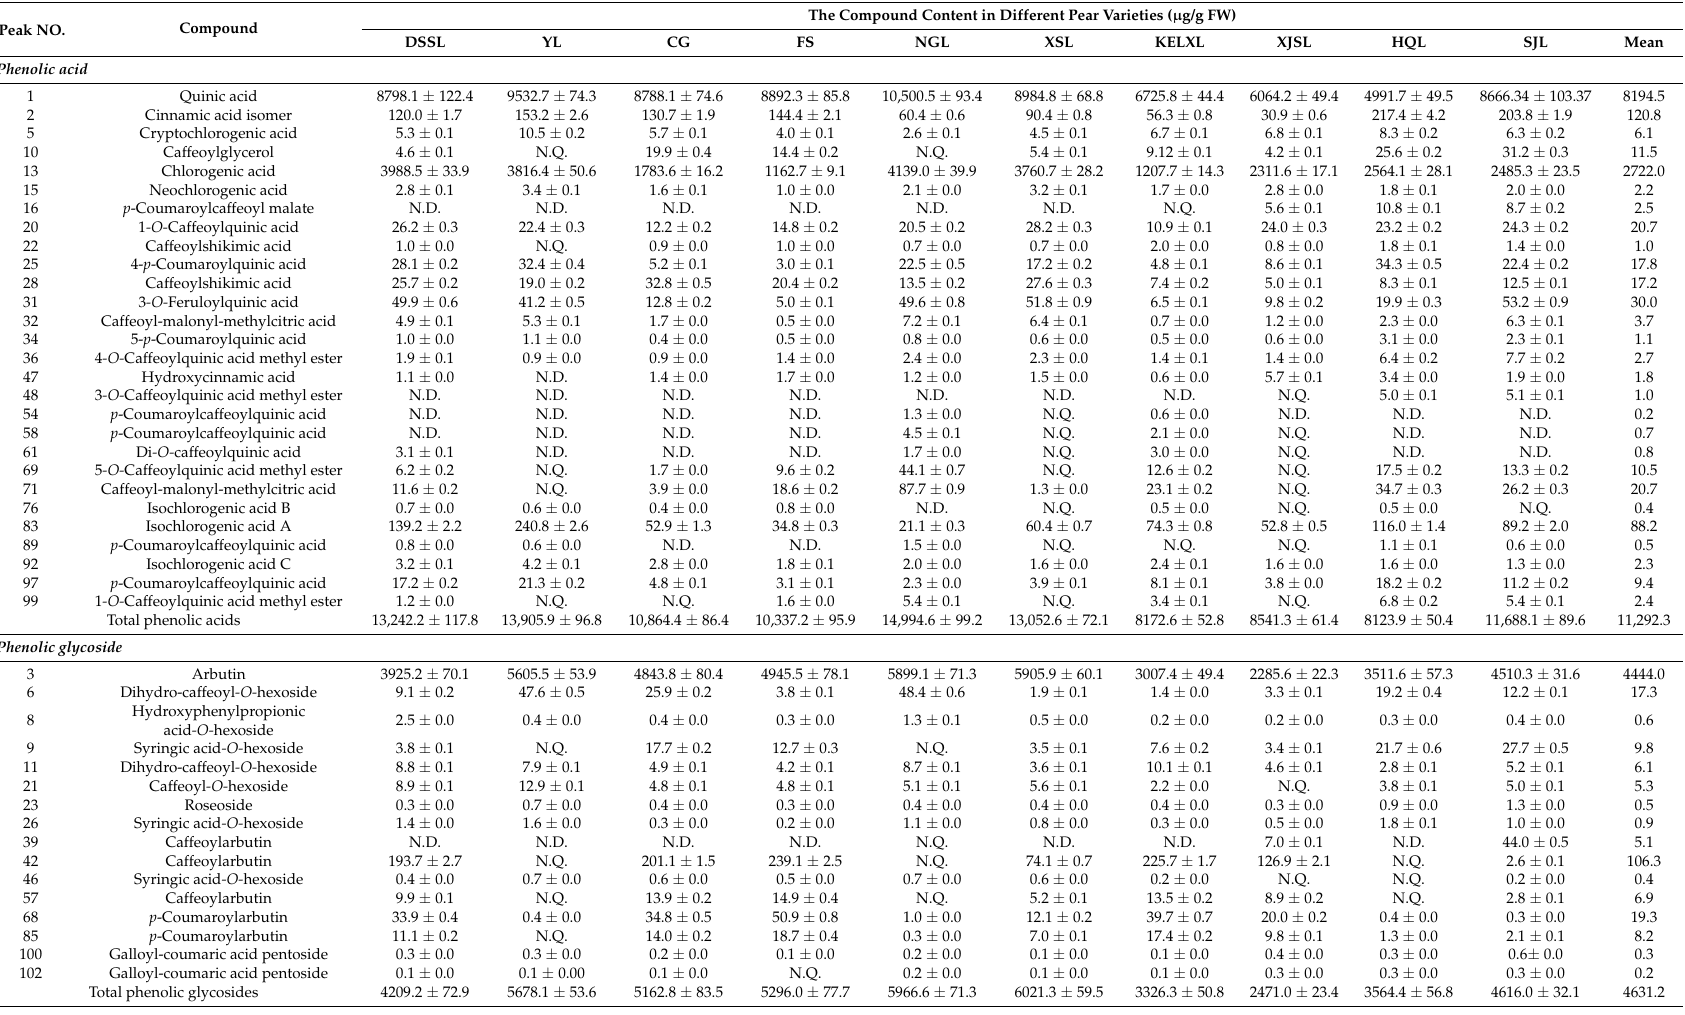
Table 3. The content of chemical constituents in thinned young pears of ten different varieties (mean ± SD, n = 3). Peak